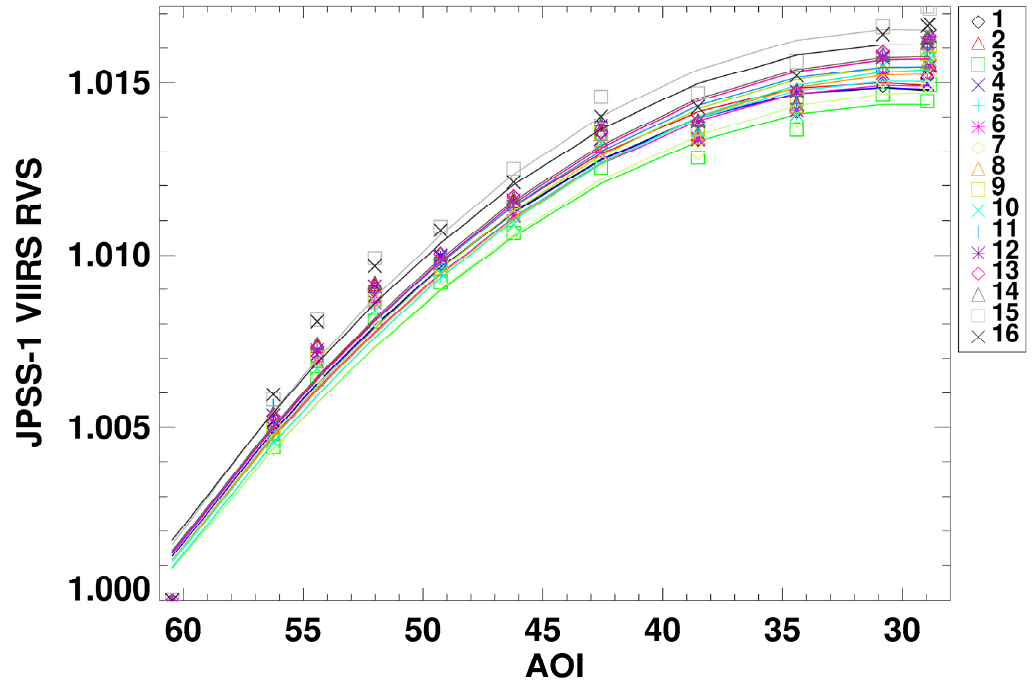
Figure 4. Band M1 HAM side A RVS and Fits for all Detectors.